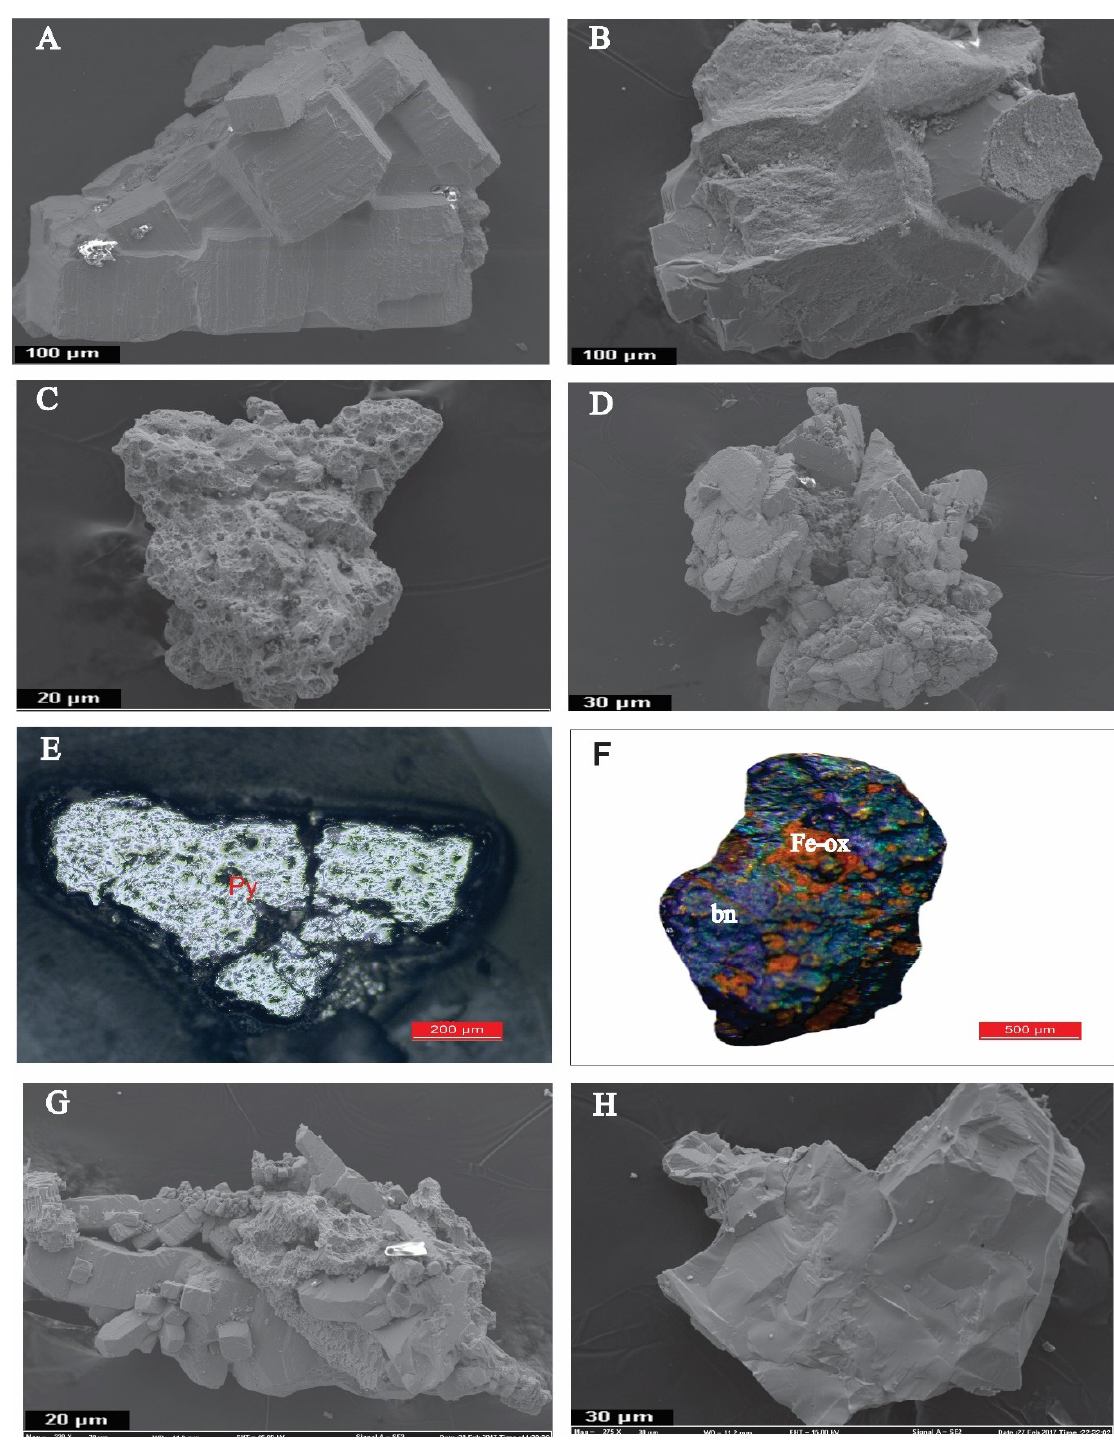
Figure 2. SEM and optical photomicrographs of typical sulfide separates: ( A , B ) euhedral pyrite and chalcopyrite separates in the Wocan-1 site (station 28I-TVGO7-28I-TVG08); ( C – F ) effect of weathering on pyrite and chalcopyrite separates in the Wocan-2 site (station 28I-TVG10); ( G , H ) micro-chimney fragments separated from bulk sediment of Wocan-1 (station 28I-TVG-08). E, F were observed